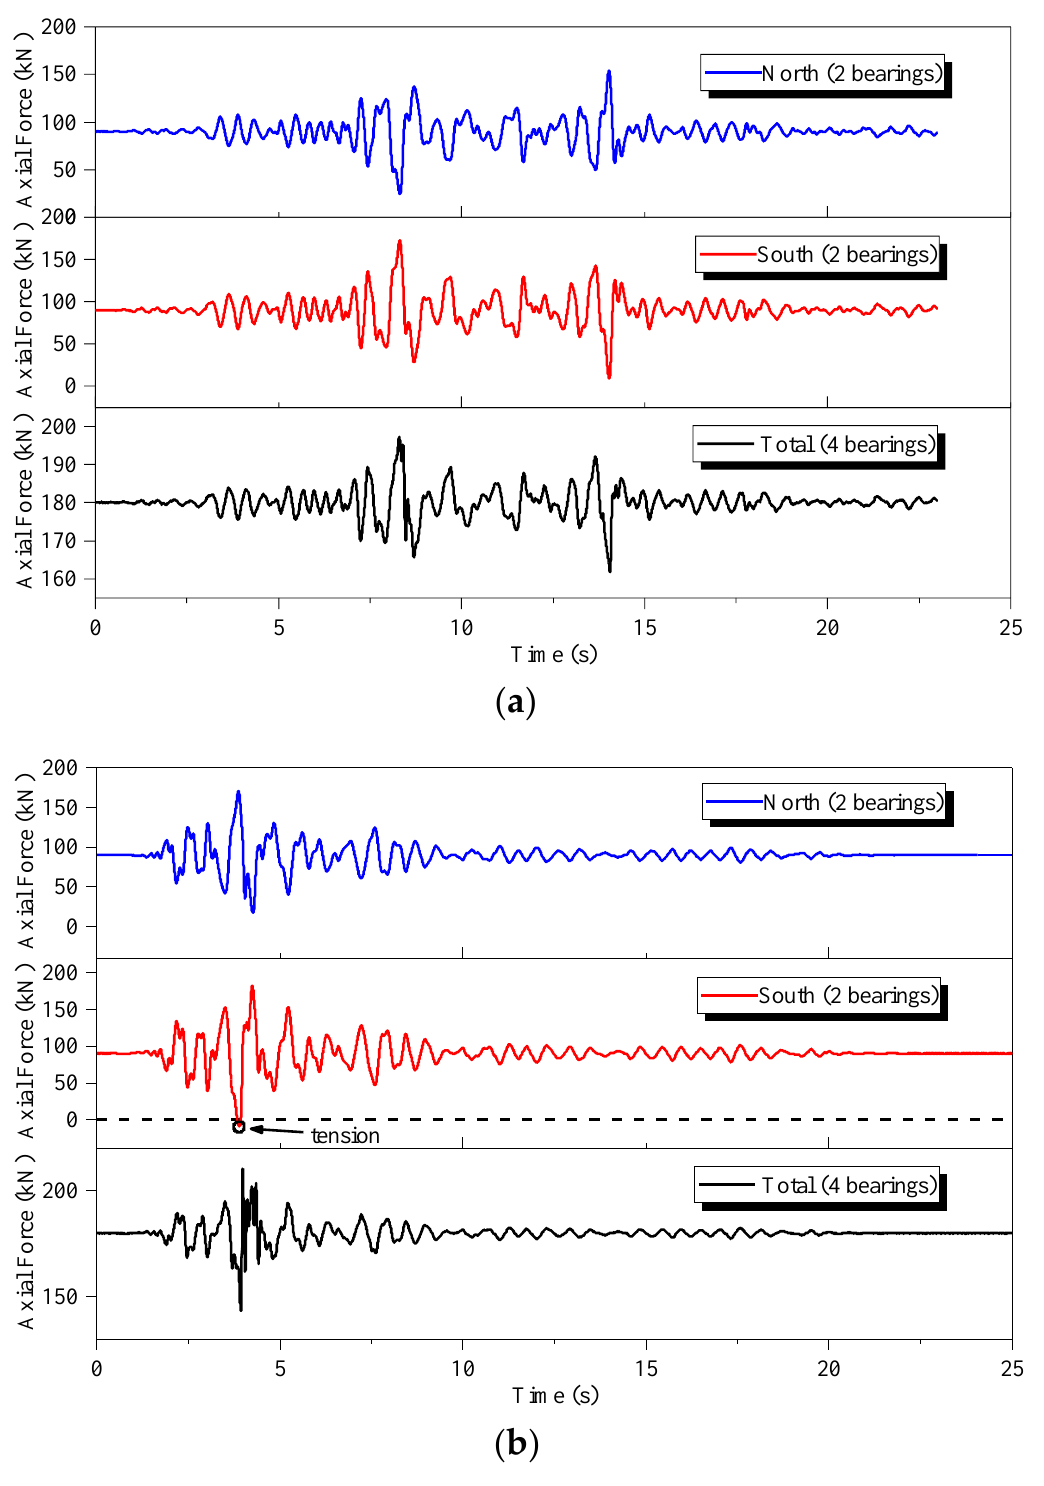
Figure 10. History of the record axial force of the LNRs subjected to: ( a ) ChiChi_NP_0.60 g; ( b ) Kobe_NP_0.60 g.